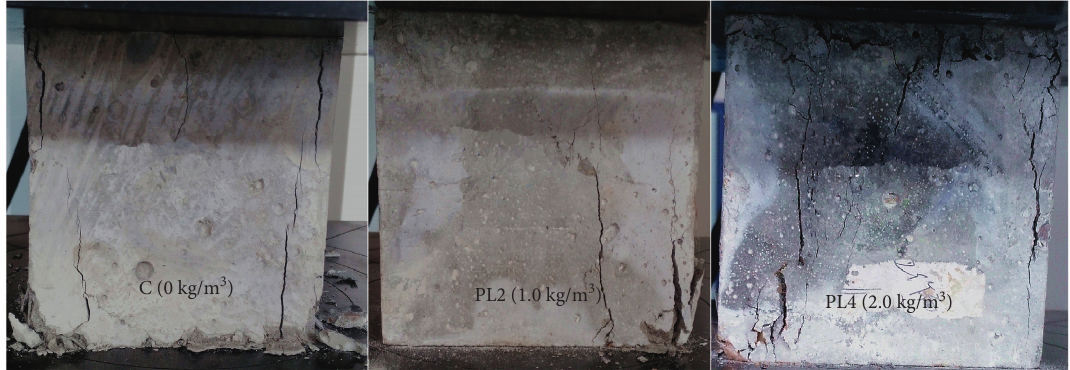
Figure 4: Failure mode of compression specimen.